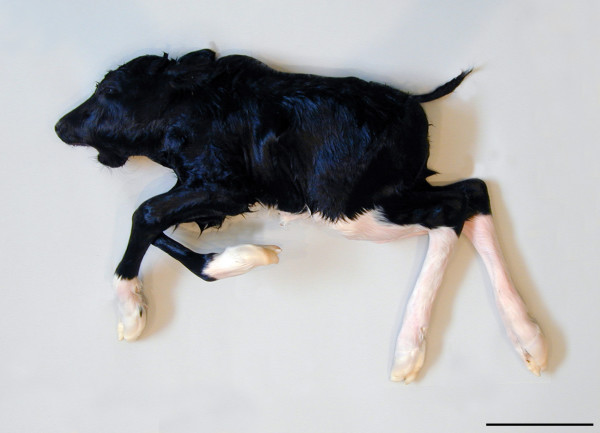
Bovine brachyspina syndrome in a Danish Holstein calf (case DK2). The calf is growth retarded with shortening of the spine and prominence of the thoracic spinous processes. Notice inferior brachygnatism and long slender legs. Bar = 15 cm.